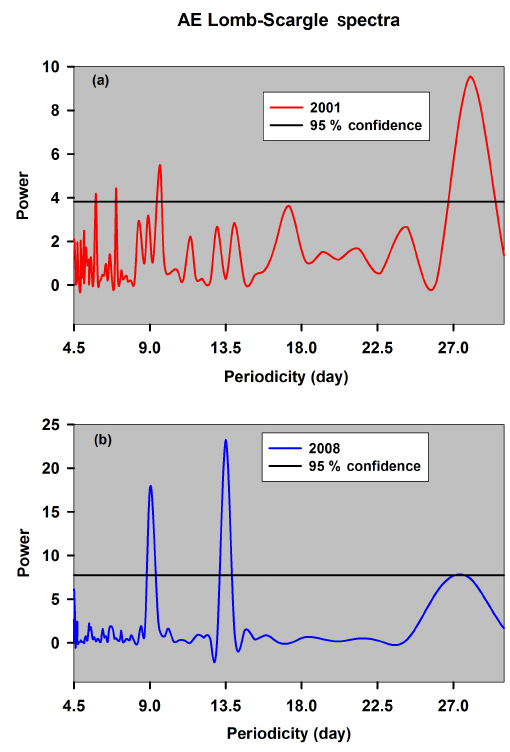
Figure 4. Lomb–Scargle spectral analysis of AE time series for 2001 (a) and 2008 (b) showing the dominance of the 27-day peri- odicity at solar maximum, while the 13.5- and 9.0-day periodicities are dominant during solar minimum at the 95% confidence level.